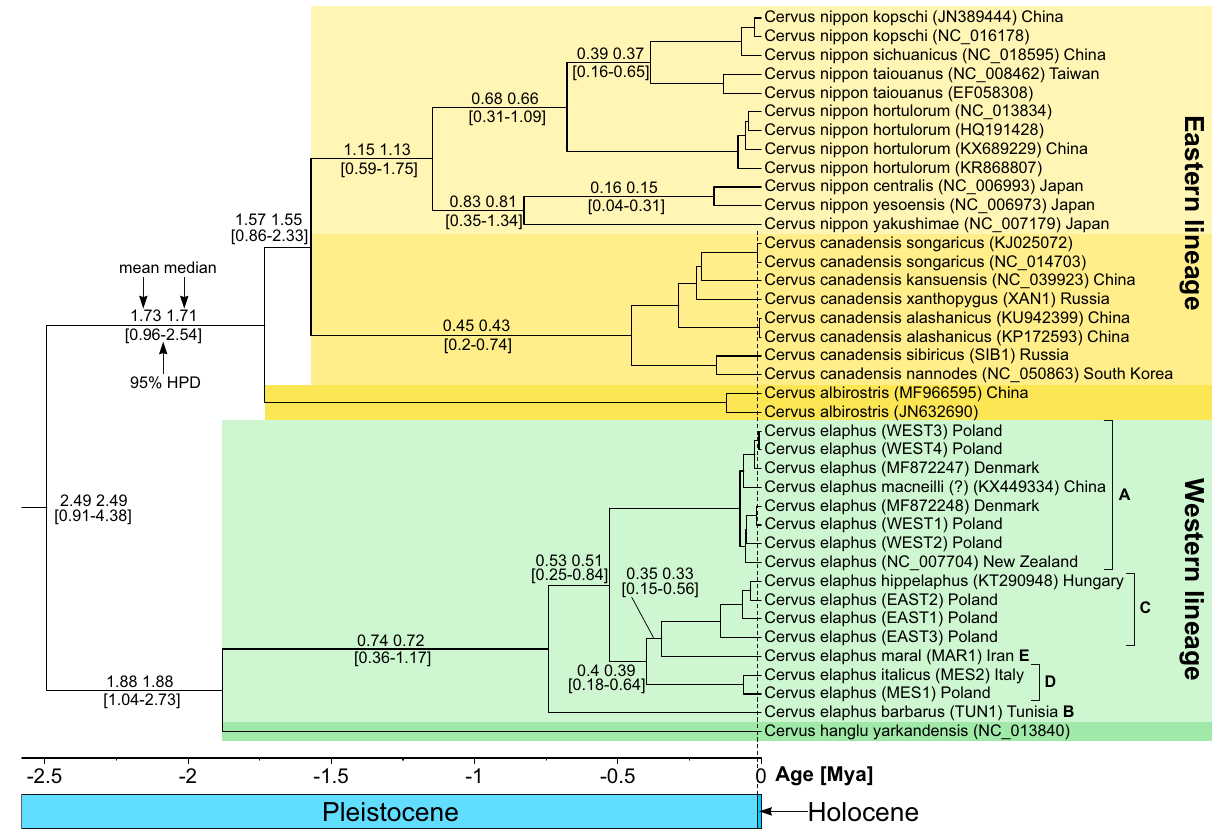
Figure 6. The chronogram for Cervus . Mean and median as well as 95% Highest Posterior Density (HPD) of individual node ages are shown at selected branches. Letters (A–E) next to Cervus elaphus clades refer to intraspecific phylogeographic